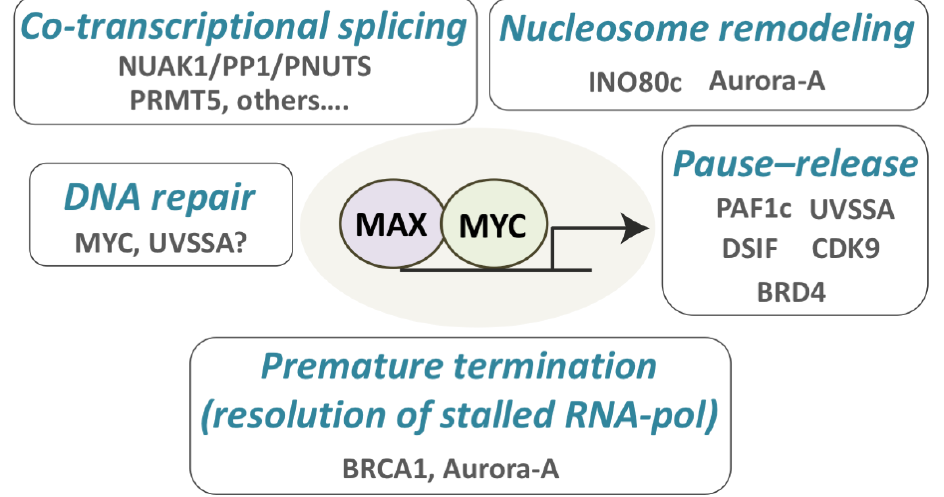
Figure 1. Processes and factors that contribute to MYC-induced hyper-transcription and are needed to prevent transcriptional